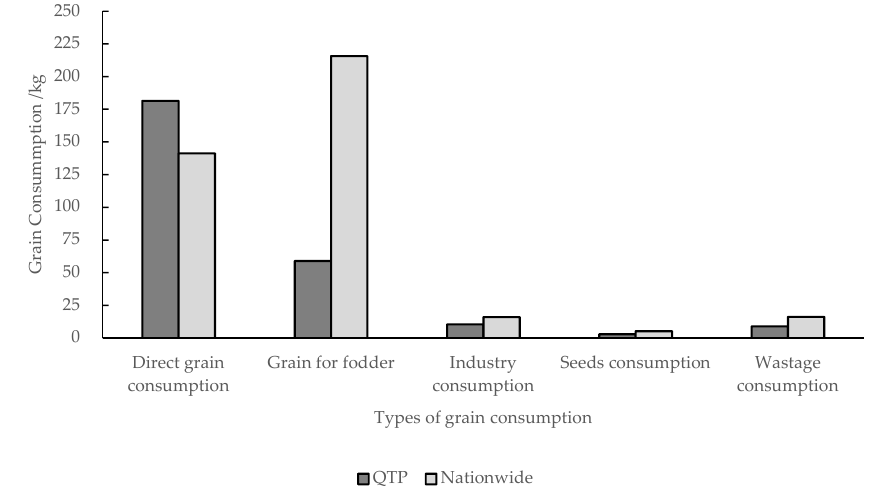
Figure 6. Per capita food consumption in the QTP and nationwide.